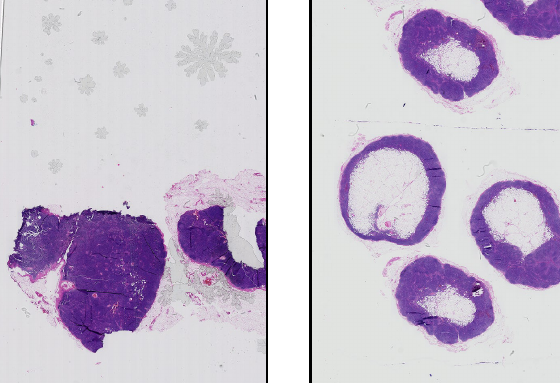
Figure 7. Low-resolution examples of whole-slide images from UMCU.